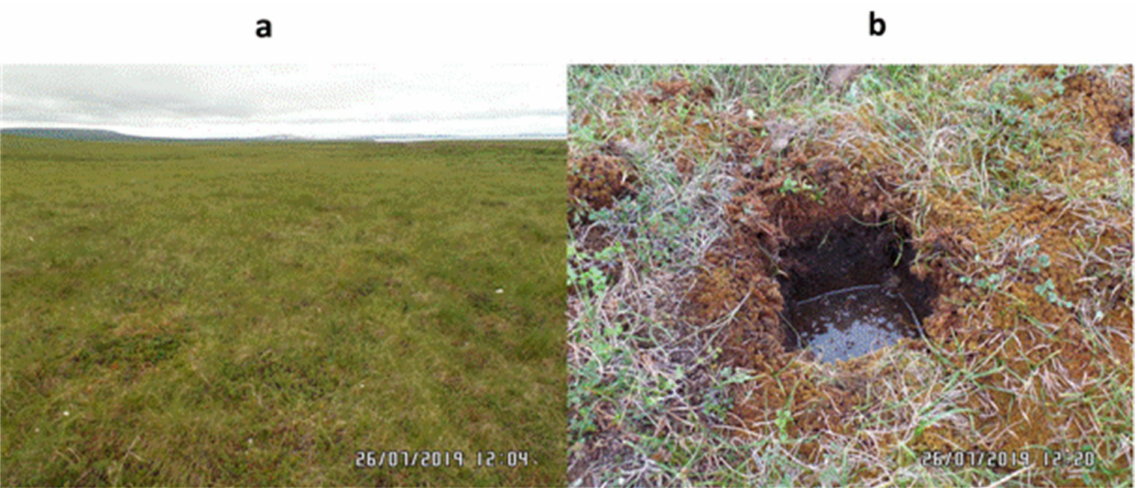
Figure 9. Hummocky moss–cotton grass tundra ( a ) on a gentle slope at the site where undisturbed samples were collected for the laboratory experiment; ( b ) a pit where sample No. 2 was removed.